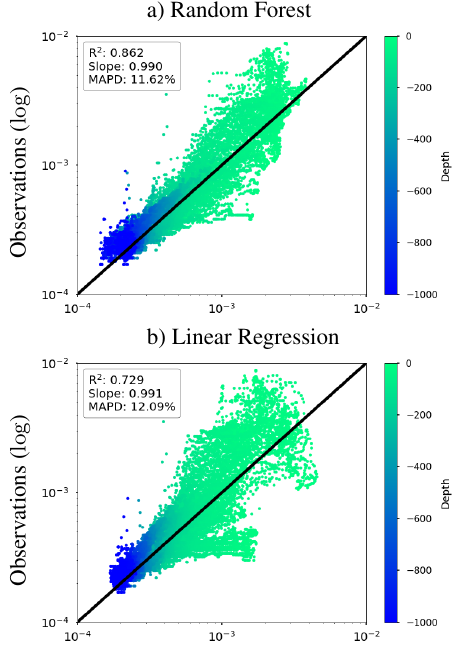
Figure 7. The resulting statistics for the validation float in the North Atlantic (WMO=6901472). The top panel a) shows the results using the Random Forest algorithm and bottom b) the results using the Linear regression. The y-axis are the observations (log-scale) and the x-axis are the predictions (log-scale). The black line is the identity line.